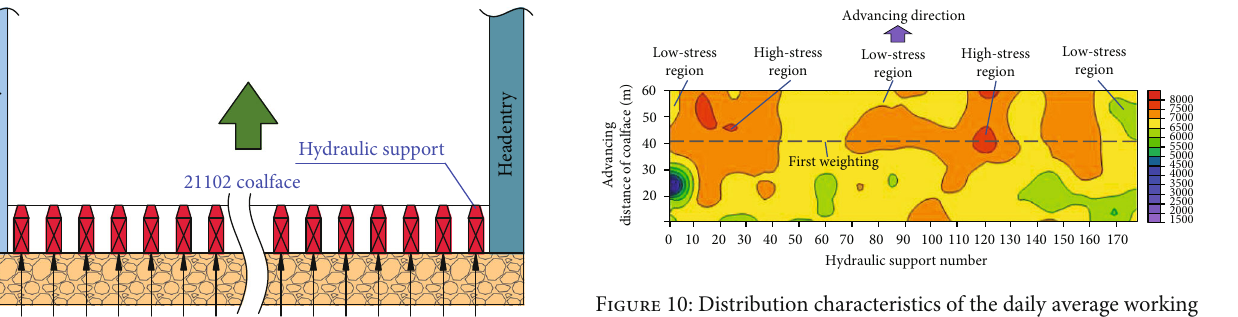
Figure 8: Distribution characteristics of stress σ and (b) planar distribution of the stress σ y .